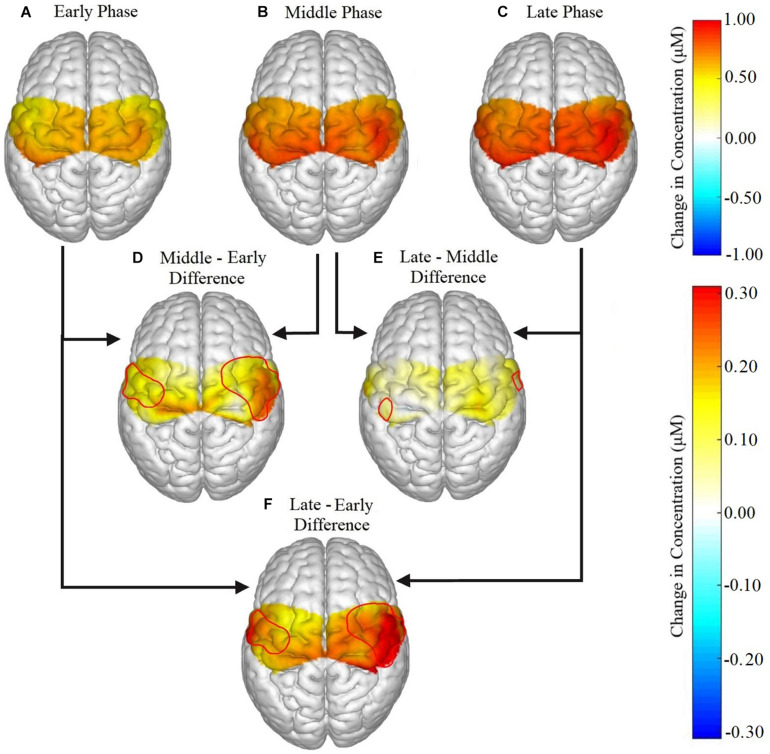
Brain activation for all participants in the (A) early, (B) middle, and (C) late phases, and the difference in activation between each phase represented as (D) middle – early, (E) late – middle, (F) late – early. Significant phase effects were found for channels 2, 4, 6, 8, 12, 14, and 18 in the ipsilateral hemisphere and in channels 5, 7, 9, and 11 for the contralateral hemisphere for (D) middle – early and (F) late – early. For (E) late – middle, the only significant differences were found in channels 14 and 11.